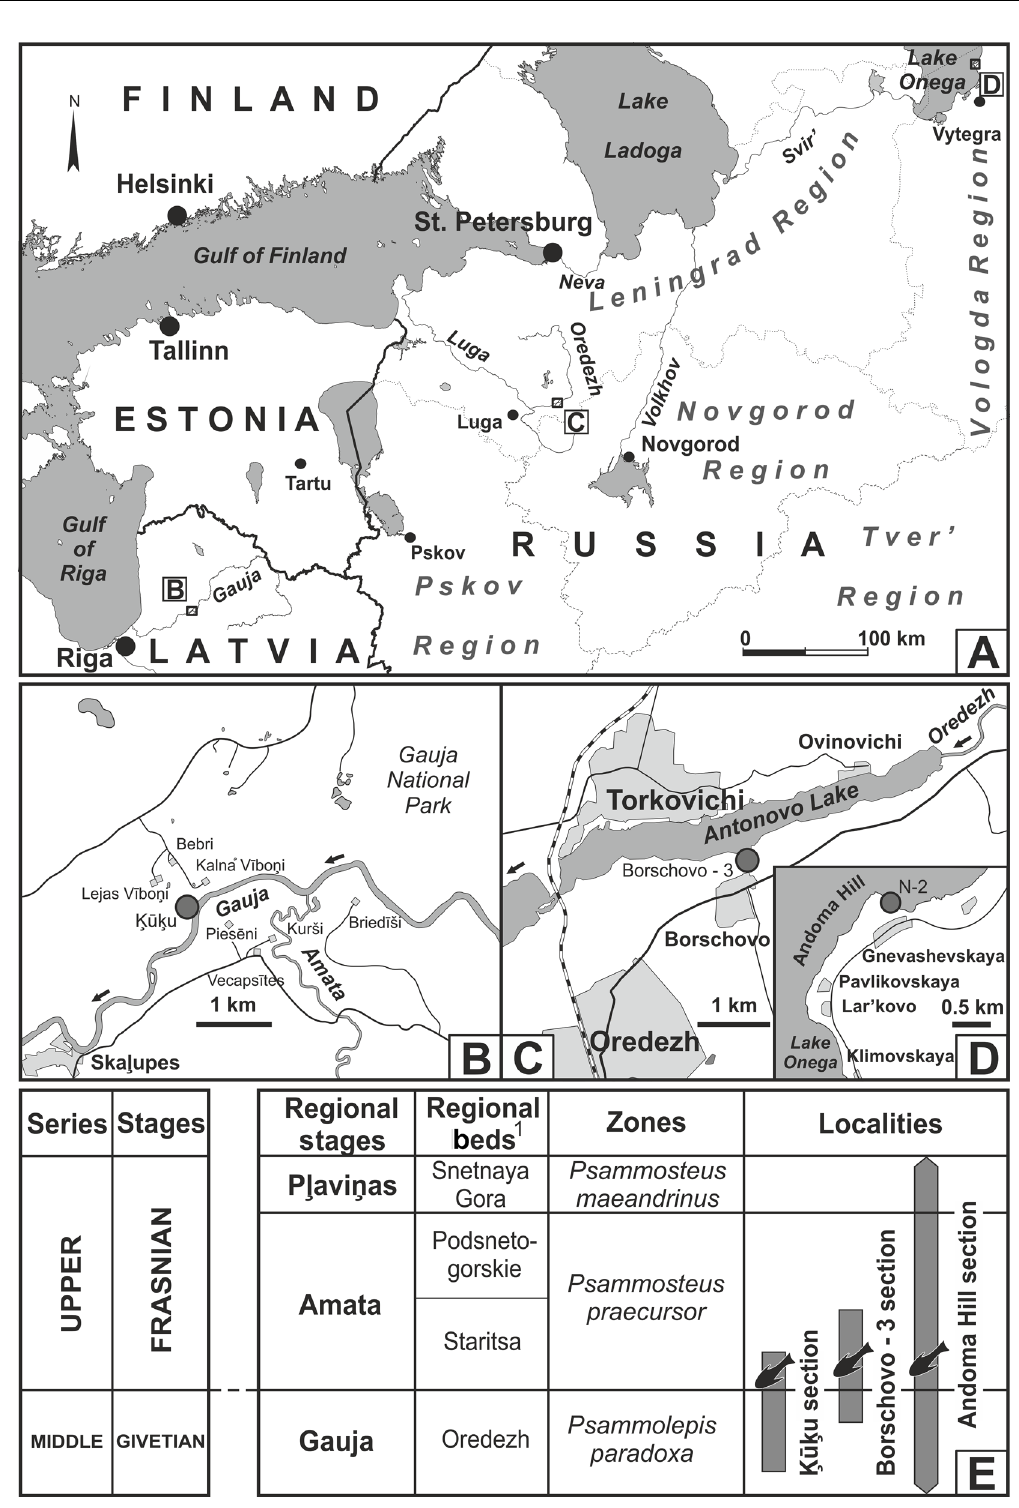
Fig. 1. A , a map showing the localities of Psammosteus ramosus sp. nov. Glinskiy from eastern Latvia and Northwest Russia. B , Ķūķ u locality on the right bank of the Gauja River, Latvia. C , outcrop 3 of the Borschovo locality, Russia. D , outcrop N-2 of the Andoma Hill locality, Russia. E , the stratigraphical position of the studied localities. 1 , Regional Beds of the eastern part of the Main Devonian Field. Black psammosteid figures mark the approximate stratigraphic levels from which the specimens of the new taxon were